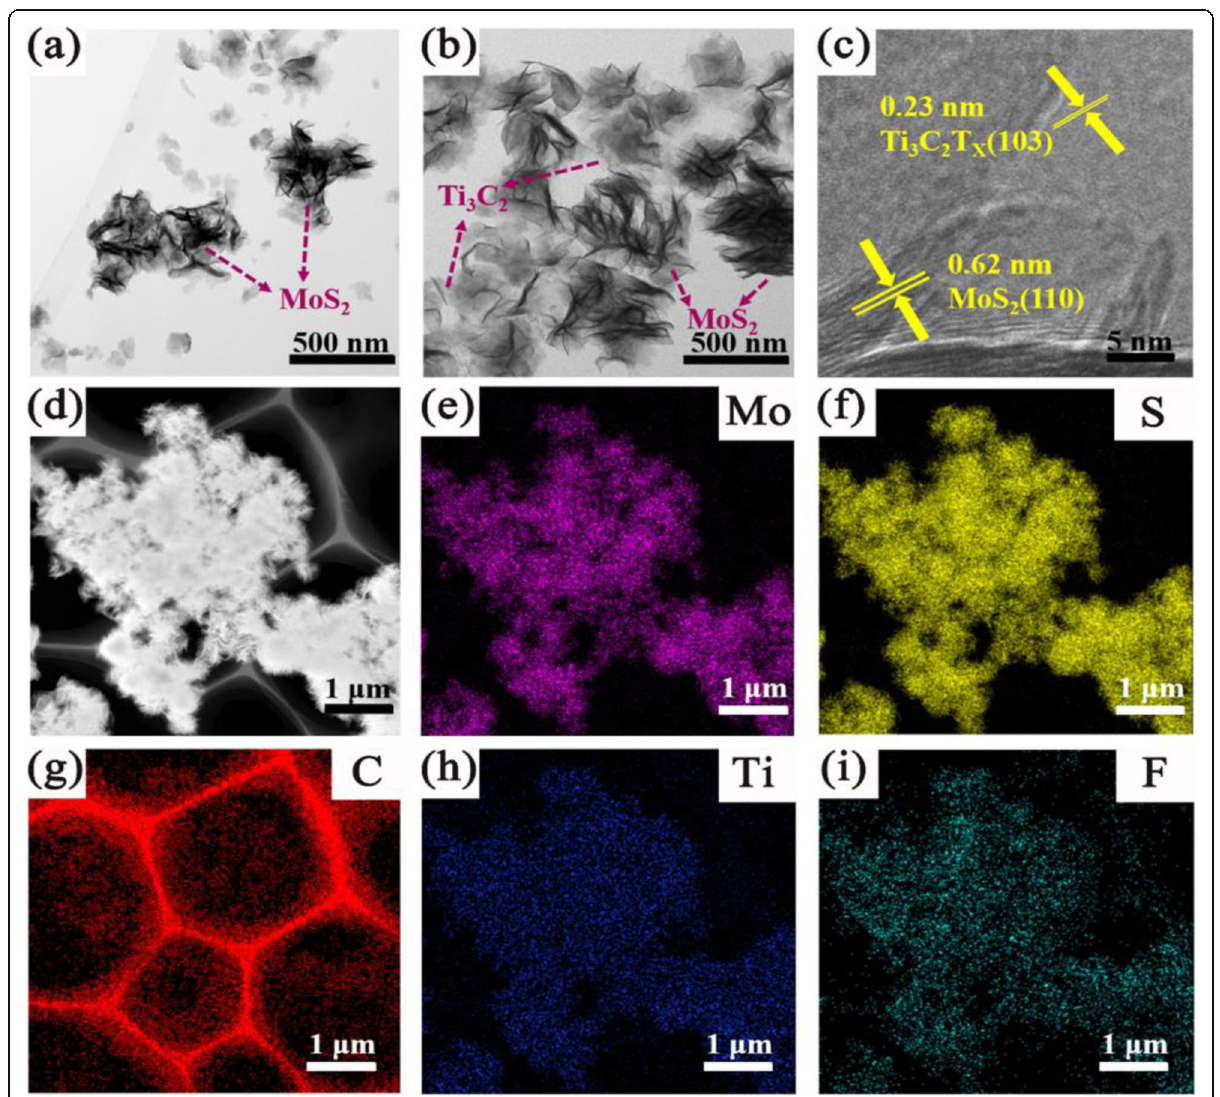
Fig. 4 a , b TEM images of TM0 and TM0.5 samples. c HRTEM image of Ti 3 C 2 /MoS 2 . d A STEM image. e , f , d , h , i EDS mapping images of Mo, S, C, Ti, and F elements of TM0.5